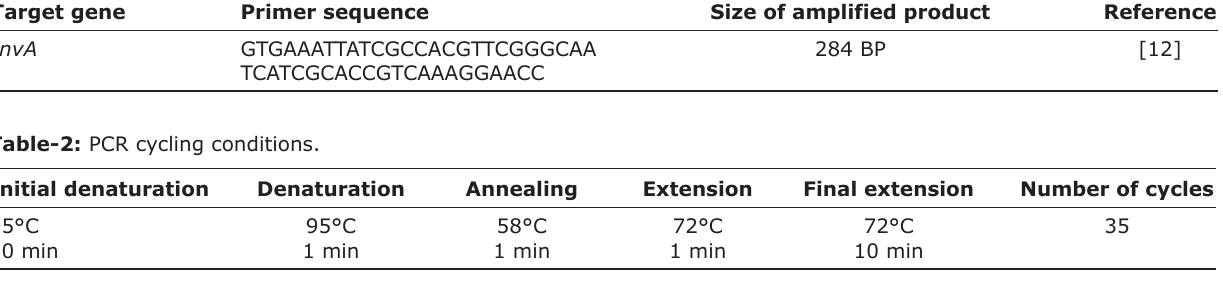
Table-3: The incidence of isolation and serological identification of Salmonella strains. Source of